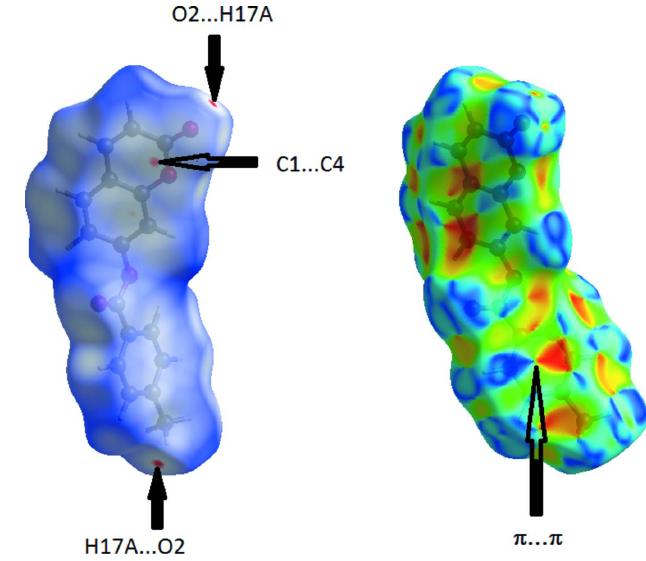
Figure 3 Hirshfeld surfaces mapped over d norm ( (cid:5) 0.043 to 1.281 a.u.) (left) and shape-index (right).